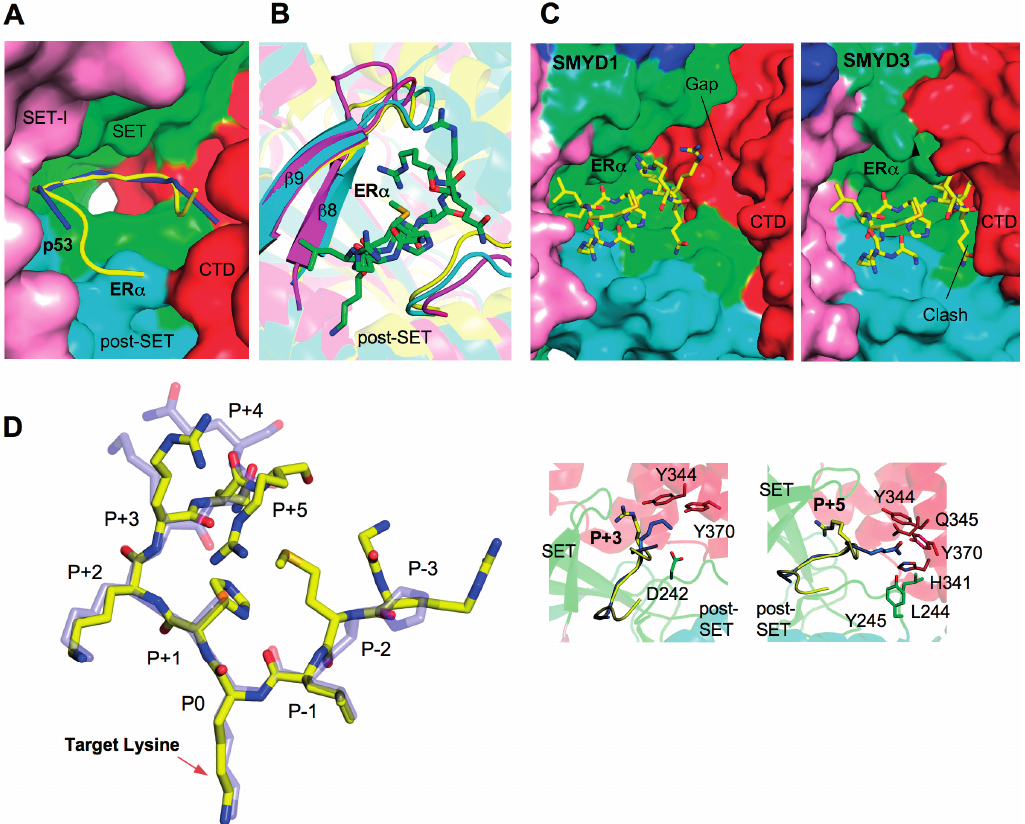
Figure 4. Substrate binding site. ( A ) Surface representation of SMYD2 substrate binding site. The surface is colored according to domains. ER α and p53 peptides are depicted by ribbons and colored in yellow and blue respectively; ( B ) Superposition of the substrate binding clefts. SMYD residues are represented by ribbons and colored according to the scheme in Figure 1C. ER α peptide is shown in balls-and-sticks colored in green; ( C ) Surface representation of the substrate-binding site of SMYD1 and SMYD3. The ER α peptide, represented by sticks, is modeled by superposition with the N -terminal lobe of SMYD2; and ( D ) Superposition of the SMYD2-bound ER α (yellow; PDB code: 4O6F) and p53 peptides (light blue; PDB code: 3TG5). Position 0 refers to the target lysine. Detailed structural and binding differences at position +3 and +5 are shown in callout boxes. Peptide-interacting SMYD2 residues are colored according to